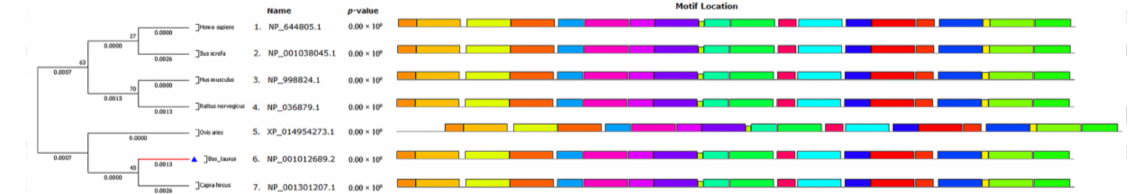
Figure 2. Phylogenetic tree ( Left ) and Motif structural analysis ( Right ) for seven species. Twenty significant motifs were identified. The length of the color block shows the position, strength and significance of a particular motif site. The length of the motif is proportional to the negative logarithm of the p -value of the motif site, truncated at the height for a p -value of 1 × 10 − 10 . These colors are given through motif analysis performed through MEME suit system. The “red line” and “blue triangle” are specifically conserved motif sites for Bos Taurus